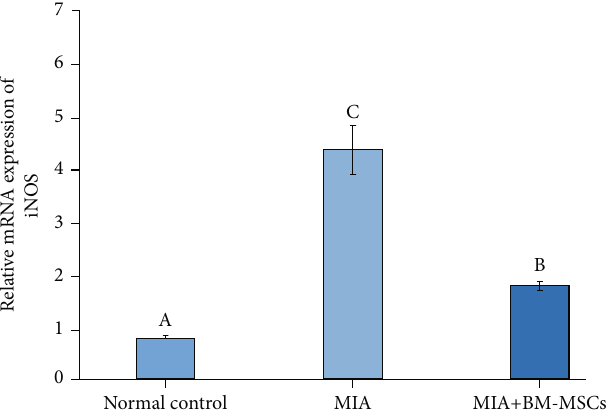
Figure 5: E ff ect of BM-MSC treatment ( 5 × 10 6 cells/rat) on the mRNA expression level of iNOS in MIA-induced osteoarthritic animals. Means, which have di ff erent symbols, are signi fi cantly di ff erent at P < 0 : 05 .